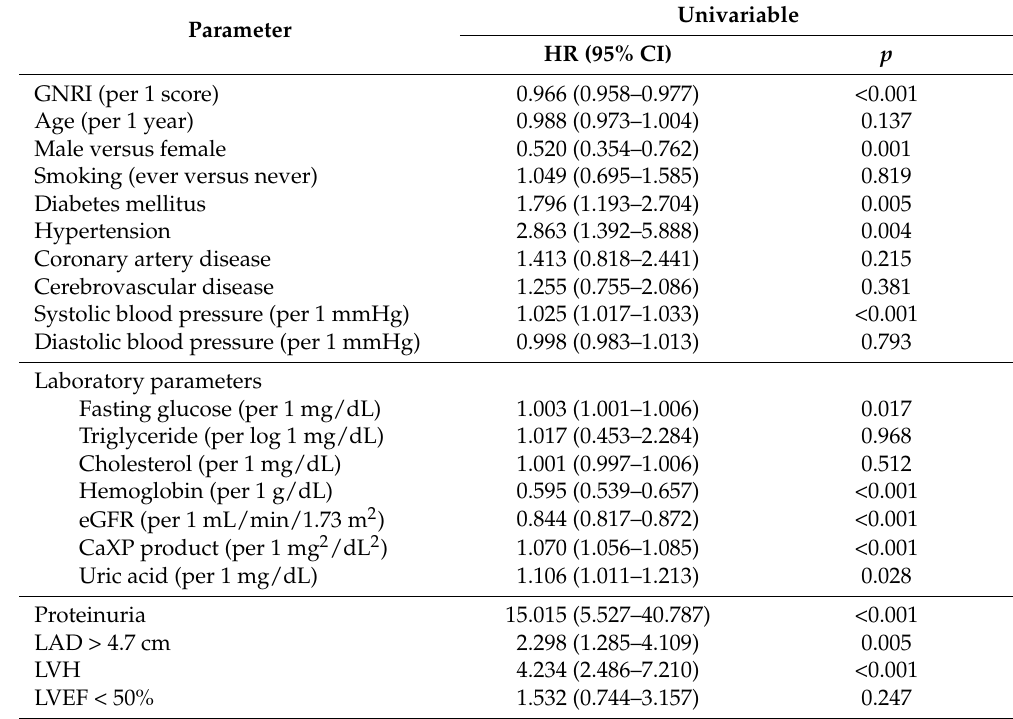
Table 4. Risk factors of progression to dialysis using the univariable Cox proportional hazards model.